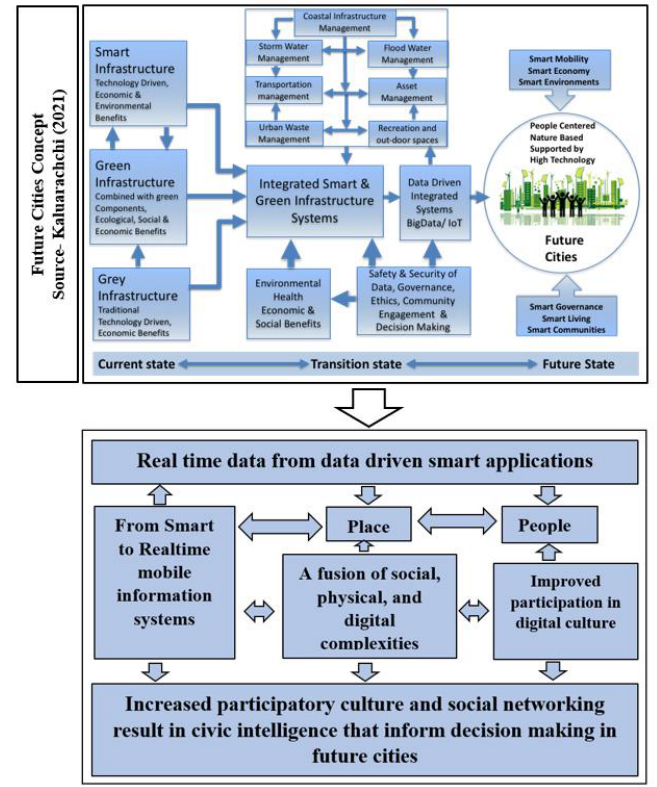
Figure 8. Real-time data promoting participatory culture.